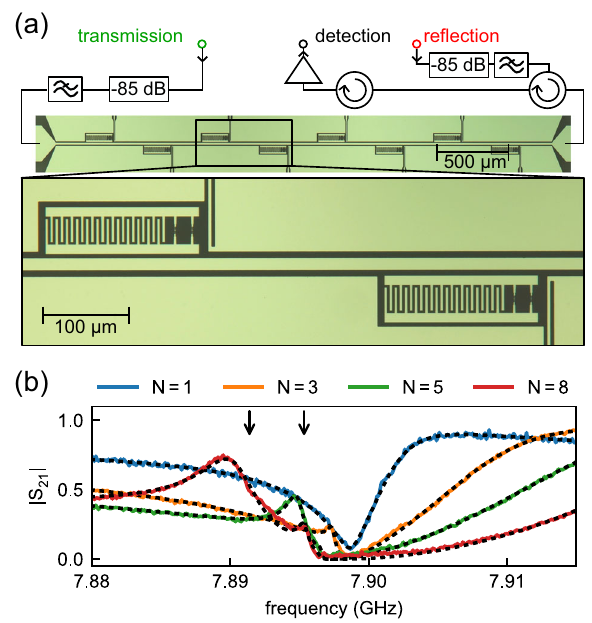
Fig. 2 Bandgap and polariton relaxation rates. a Dependence of absolute transmission ∣ S 21 ∣ 2 on the number of resonant qubits N . Crosses mark calculated eigenfrequencies ω ξ of H eff and their corresponding radiative decay rates Γ ξ / Γ 10 (color coded). With increasing N a bandgap of strongly supressed transmission opens up. b Measured radiative decay rates Γ ξ of the brightest (blue crosses) and second brightest (red crosses) subradiant states. Orange and blue solid triangles are the corresponding calculated rates, the green line is the analytical result Γ ξ = 8 N 3 φ 2 / π 4 . For the brightest subradiant state, a fi t to a power-law with exponent b